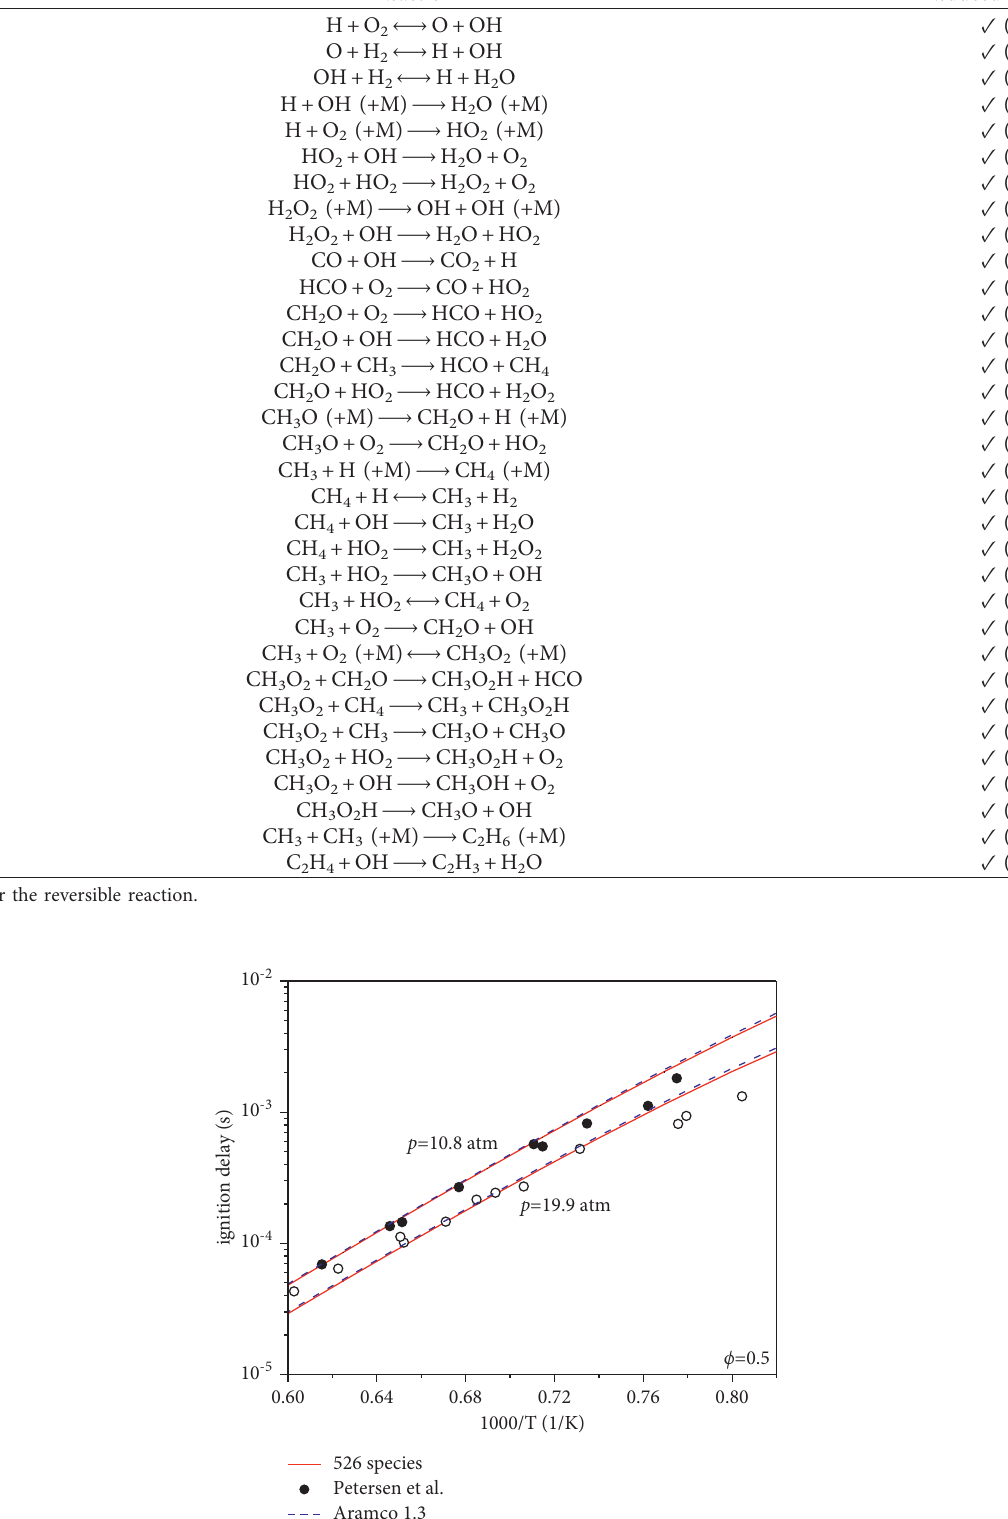
Figure 3: Ignition delay times validation for methane. The experimental data used for comparison were taken from Petersen et al.